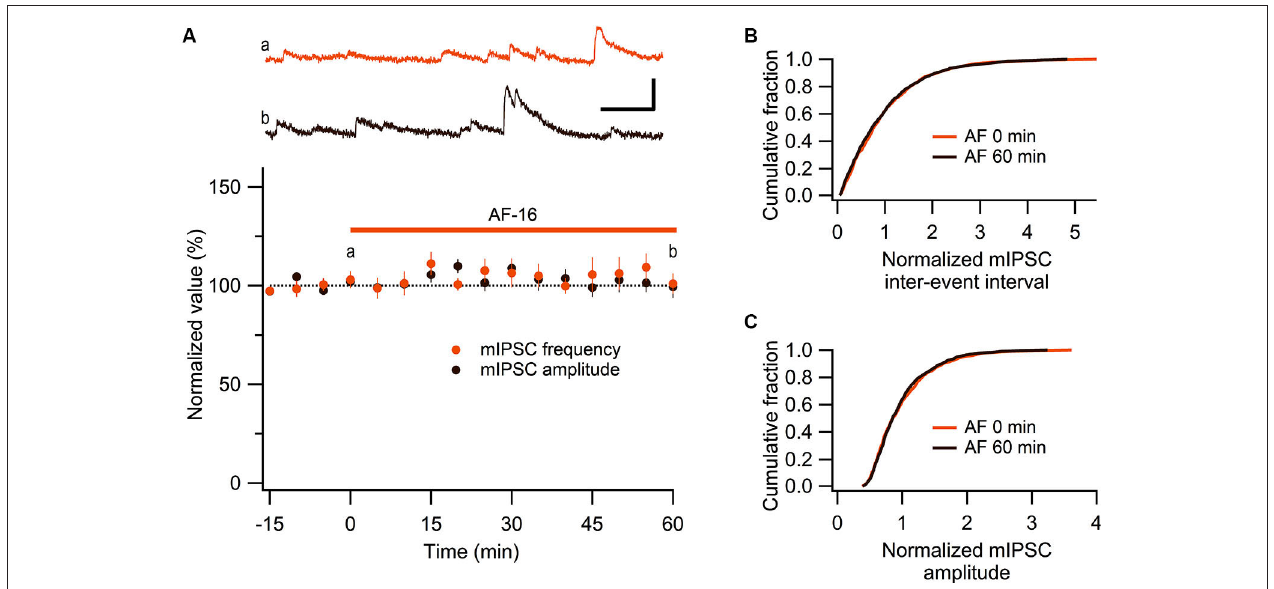
(dark brown trace 60 min after the application of AF) are shown at the top, scale bar represents 20 pA and 100 ms. (B) Effect of AF-16 on the cumulative distribution of mIPSC inter-event intervals ( n = 6). (C) Effect of AF-16 on the cumulative distribution of mIPSC amplitudes ( n =